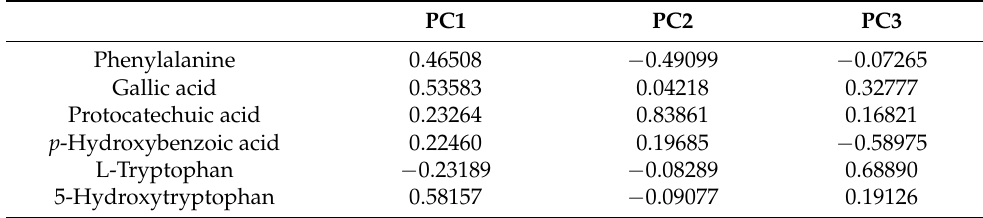
Table 4. Values of loadings of three components PC1, PC2, and